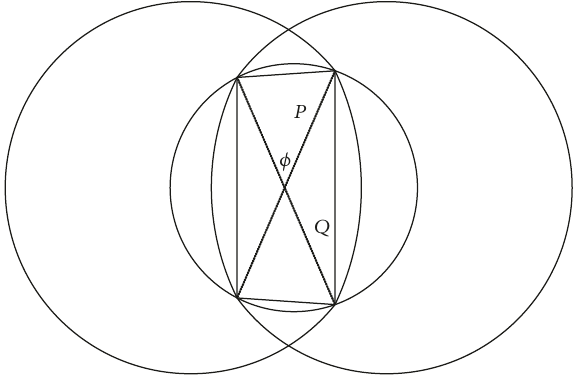
Figure 10: Formation of irregular convex quadrilateral.